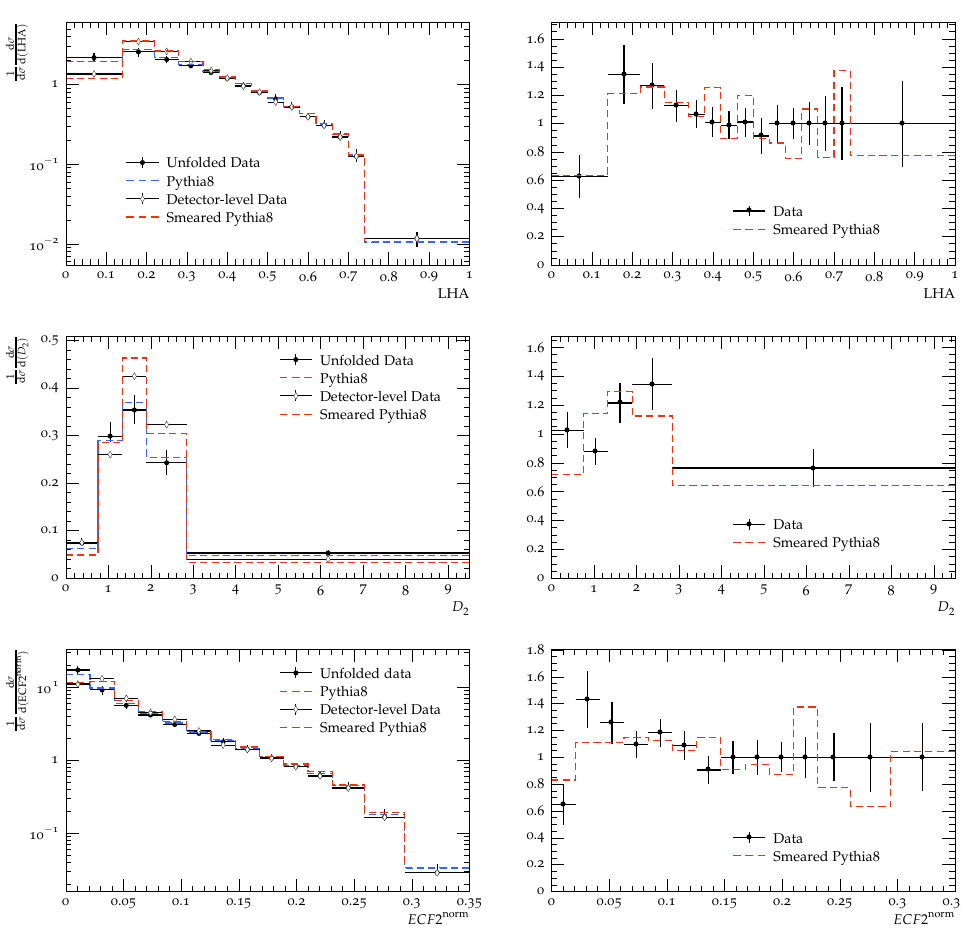
Figure 7: The effect of tuned jet constituent smearing without a calorimeter granularity emulation, on reconstruction-level data in Ref. [ 40 ] . The LHA, D observables are shown respectively in the rows from top to bottom, with the observed data compared to truth & smeared predictions in the left column, and the bin-by-bin transfer functions used for tuning in the right